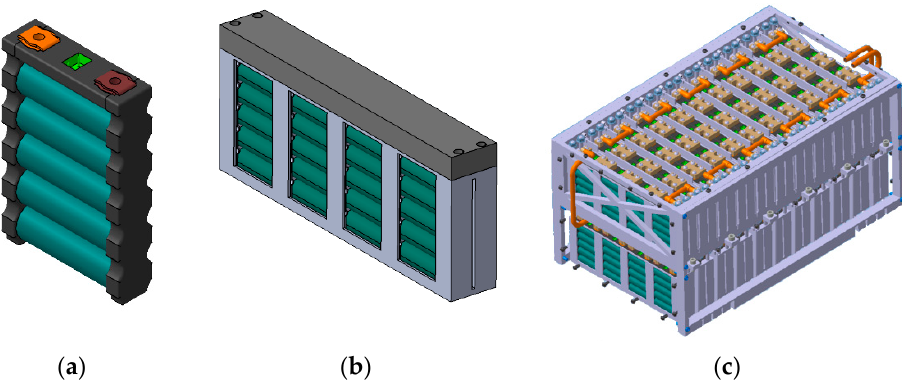
Figure 2. ( a ) Battery module; ( b ) battery segment; ( c ) battery pack.